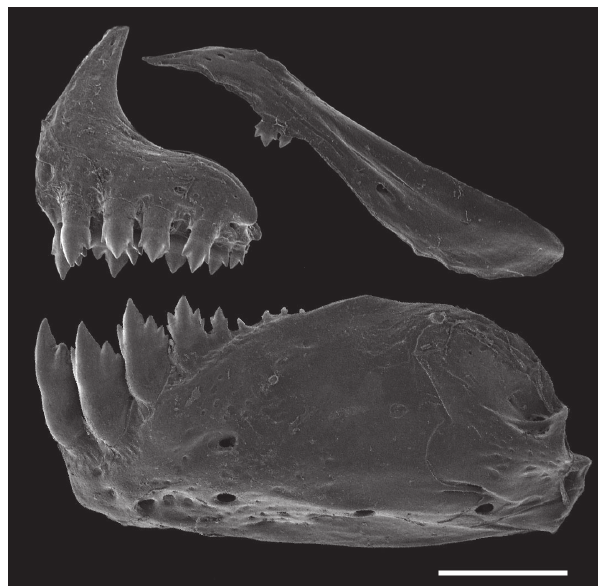
Fig. 2. Upper and lower jaws of Hasemania kalunga , UFRGS 11289, paratype, female, 36.2 mm SL, lateral view, left side. Scale bar = 1 mm.